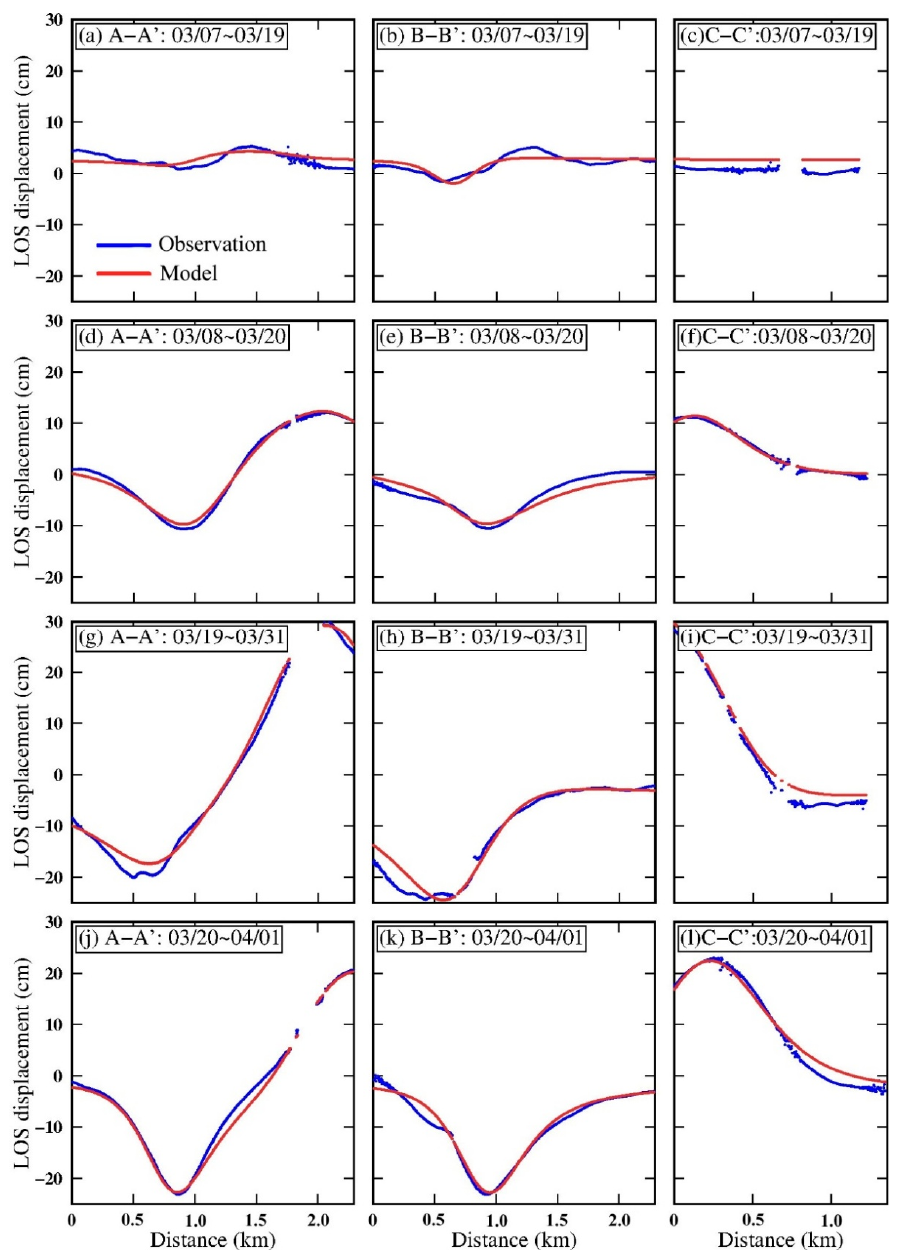
Figure 4. Comparisons of observed and modelled displacements on profiles.